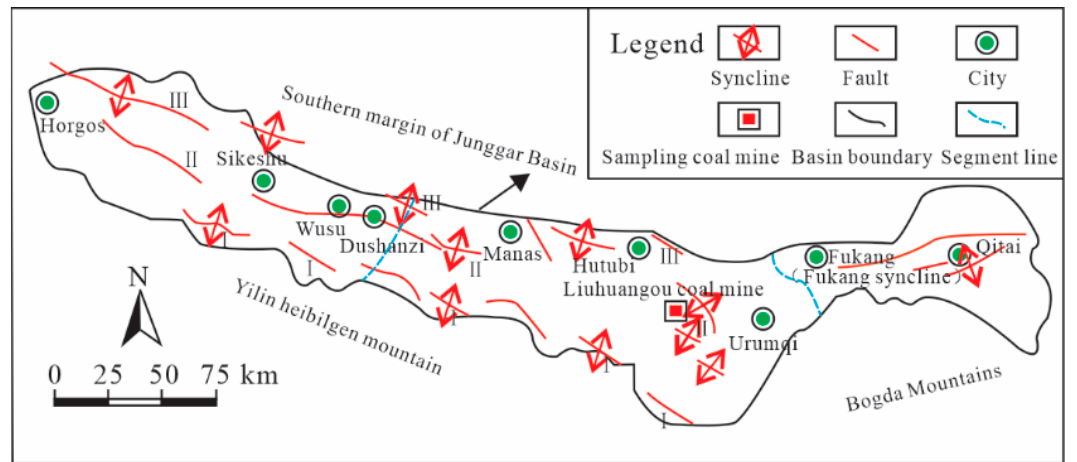
Figure 1. The southern boundary of Junggar basin’s structural outline map and sampling mine distribution map.